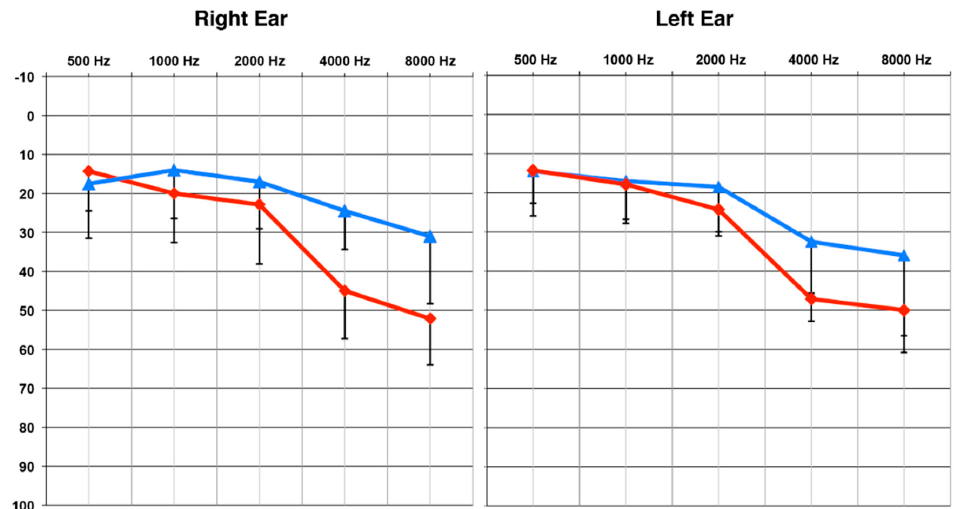
Figure 1. Group Mean Pure Tone Thresholds. The MILD hearing loss group ( n = 10) is designated by the blue line and the MOD hearing loss group ( n =7) by the red line. Standard deviations are represented by negative-going error bars at each frequency. Tested frequencies (Hz) are shown on the horizontal axis and intensity levels (dB HL) on the vertical axis.